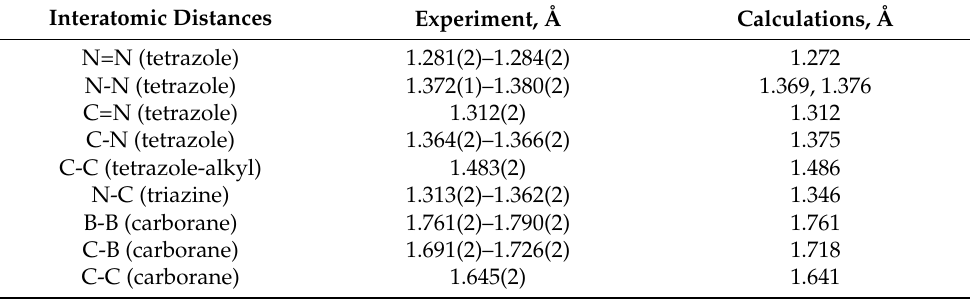
Table 1. Comparison of the experimental and theoretical interatomic distances for molecule 10